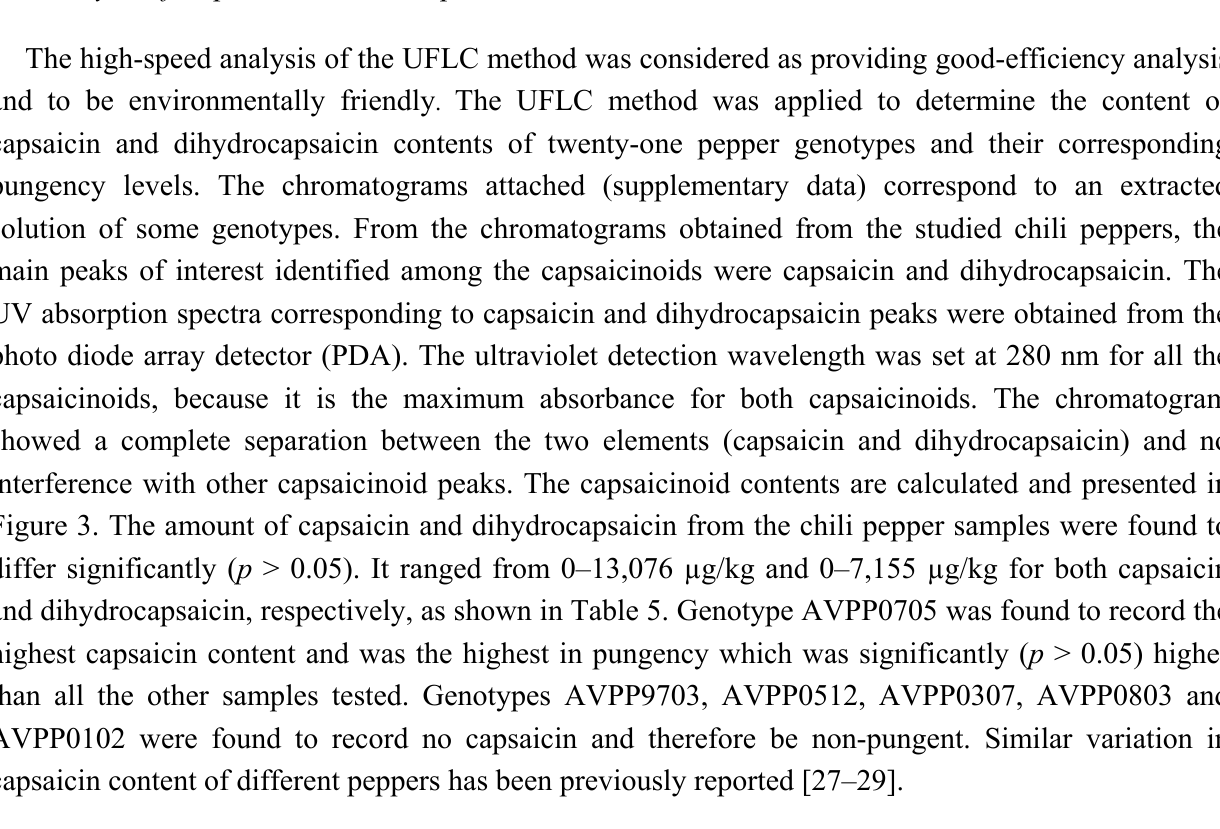
Figure 3. Capsaicin and dihydrocapsaicin obtained using acetonitrile as extraction